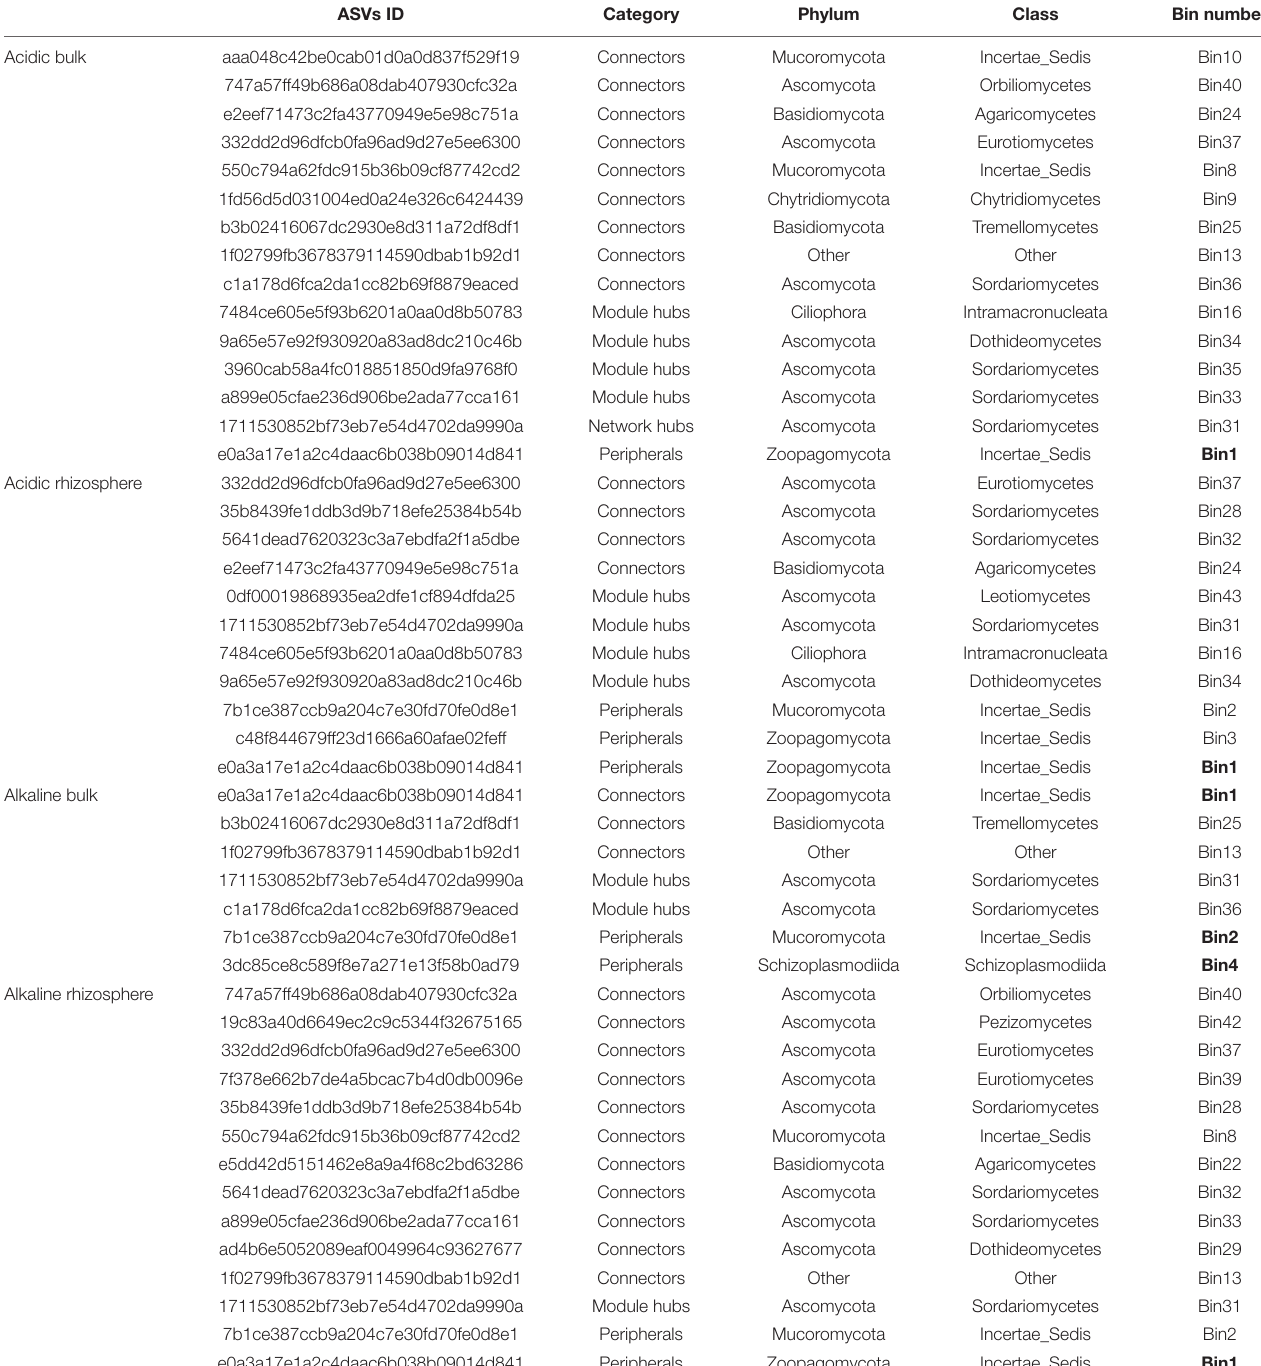
TABLE 3 | The roles of different iCAMP microeukaryotic lineage bins within the microeukaryotic co-existence